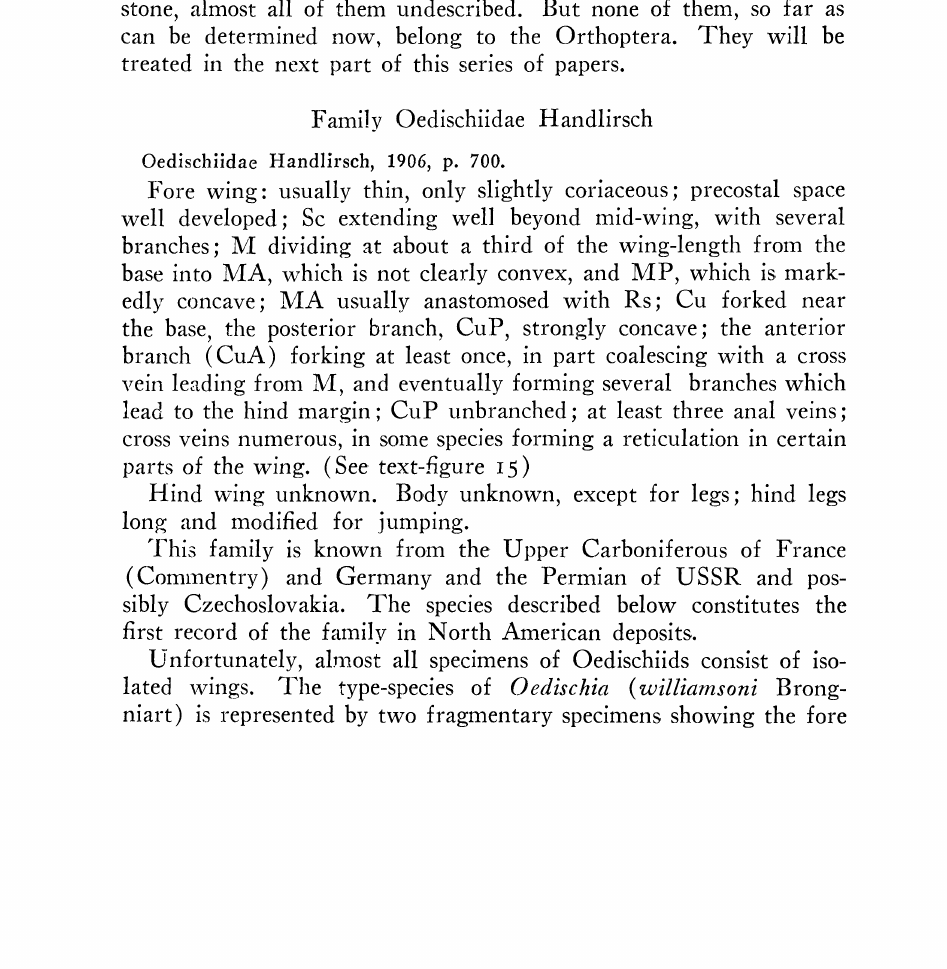
Text-figure 15. Oedischia illiamsoni